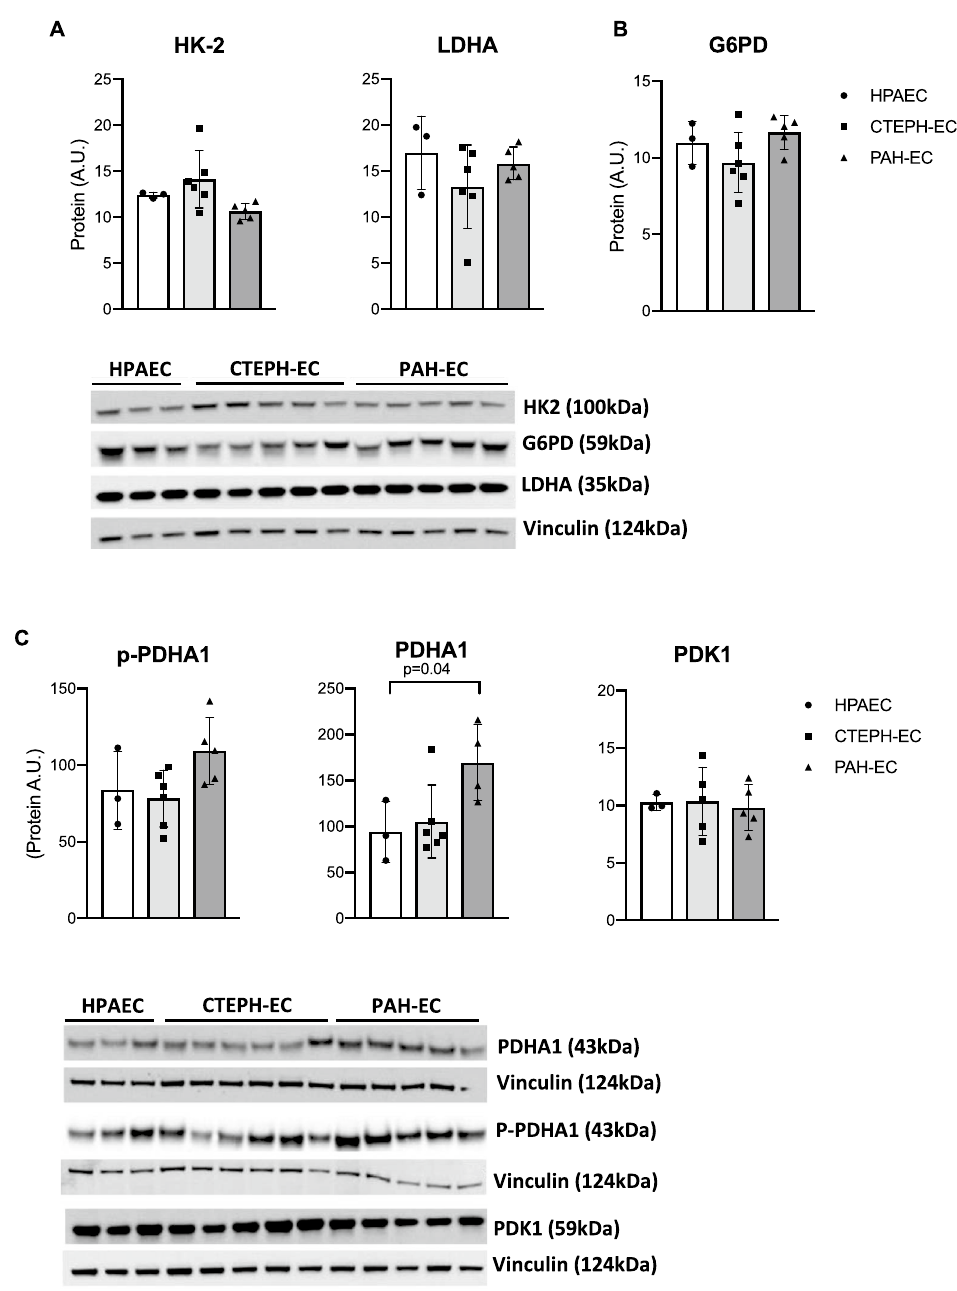
Figure 3. Protein expression of key metabolic enzymes. ( A ) Protein levels of HK2 and LDHA in CTEPH-EC, PAH-EC and HPAEC. ( B ) Protein levels of PPP key enzyme G6PD were similar in all three groups studied. ( C ) Protein levels of the phosphorylated E1 alpha PDH subunit (p-PDHA-1), PDHA1 (non-phosphorylated subunit) and PDHA1 inhibitor, PDK1 in all three groups. CTEPH-EC, n = 5–6; PAH-EC, n = 5; HPAEC, n = 3; Kruskal–Wallis test followed by Dunn´s multiple comparisons test, p < 0.05 = *; data is expressed as mean ± SD. Statistical analysis was performed with GraphPad Prism 7 software, version 7.0e, serial number:GP7- 0,633,739-R###-#####, https:// www. graph pad. com. (full-length gels are presented in supplementary material Fig.